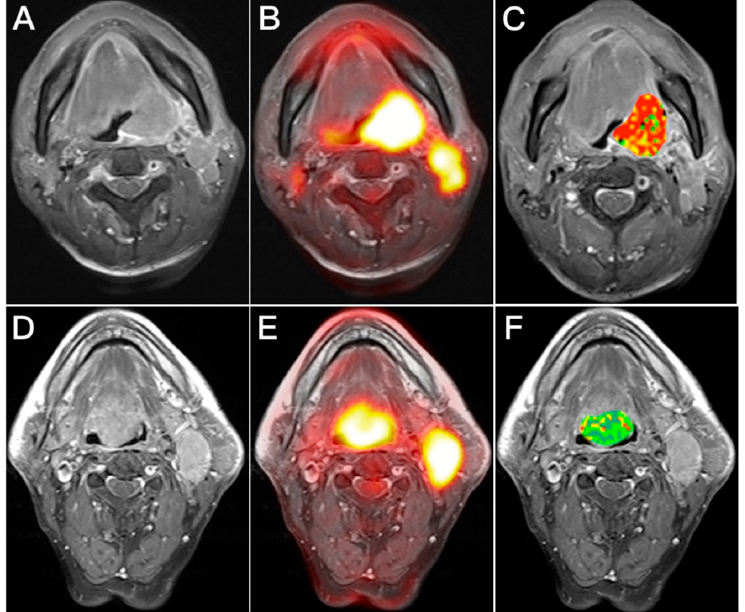
CI, confidence interval; MTV, metabolic tumor volume; SUV max , maximum standardized uptake value; ADC , apparent diffusion coefficient; K trans , volume transfer constant; K ep , flux rate constant; V e , extracellular volume ratio; iAUC, initial area under the curve; D*, pseudo-diffusion coefficient; f, perfusion fraction; ns, not significant.